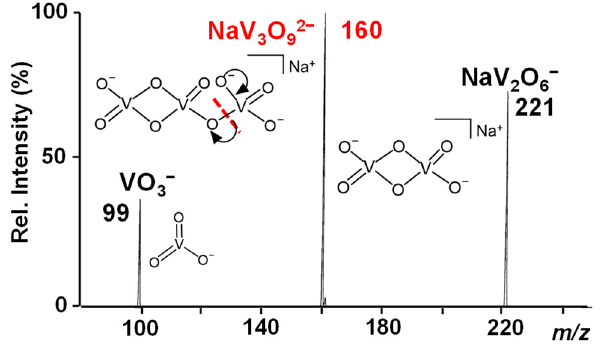
Figure 1. IT CID mass spectrum of the NaV3O9 2 − reactant ion at m / z 160.